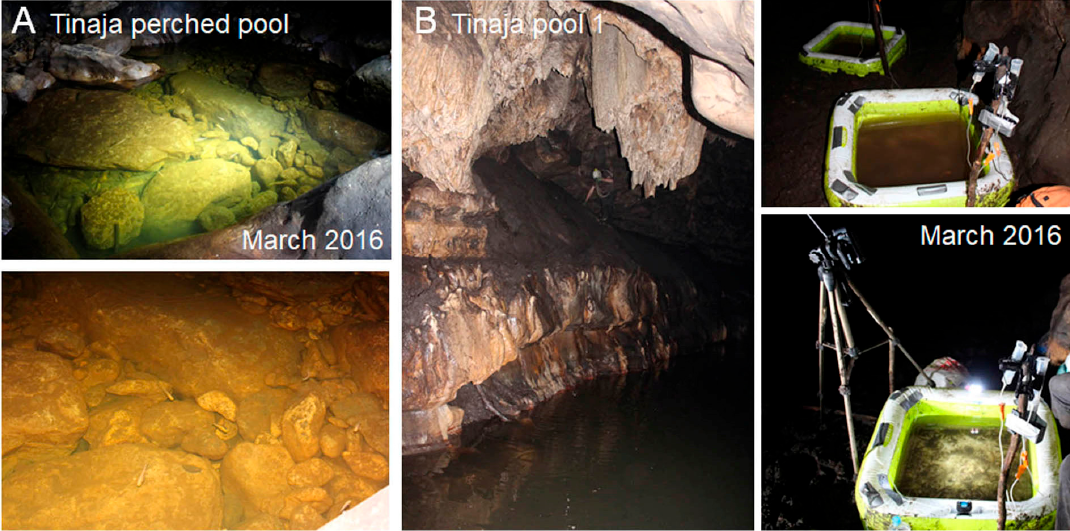
Figure 7. Experimentation in the Tinaja cave; ( A ) single test was “manually” performed in Tinaja perched pool, a very small (~3–4 m 2 ) and shallow natural pool where water is retained between rocks. There, over the years, we repeatedly observed 20–30 fully troglomorphic fish, presumably trapped there during the rainy season. The water is crystal clear; ( B ) Preliminary experiments were performed in March 2016 in Tinaja pool 1 (called Traverse Lake), a relatively large and muddy water reservoir. At the time, films were recorded in the light (instead of in the dark with infrared) and the perfusion system and the odorant molecules perfused were still under tuning. This type of expedition was of paramount importance to improve and establish the final experimental setup and design we used successfully in 2017 and 2019 in other caves.